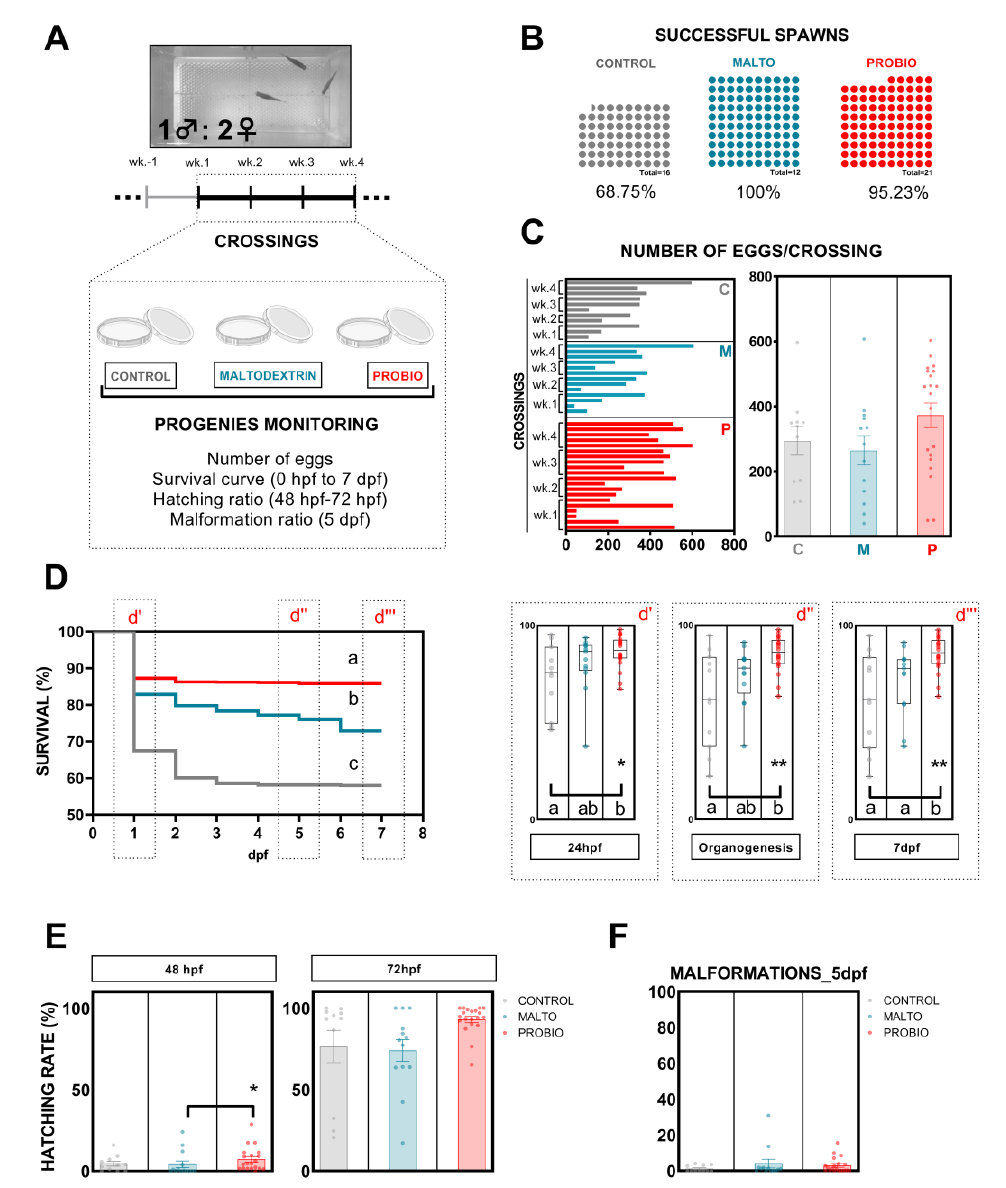
Figure 3. Probiotic ingestion positively affects zebrafish reproduction in terms of egg production and progeny quality. ( A ) Diagram summarizing design and all parameters analyzed involving each progeny. ( B ) The effect of experimental diets on the percentage of successful spawns, ( C ) total number of eggs spawned per crossing, ( D ) F1 survival (Kaplan–Meier curves (0–7dpf) and Box graphs (whiskers show min. to max.) at different key temporal points), ( E ) hatching rate at 48 hpf and 72 hpf, and ( F ) malformation rate. Data are presented as means ± s.e.m. “CONTROL/C”, “MALTO/M”, and “PROBIO/P” refer to the experimental groups: control diet-fed, maltodextrin-fed, and probiotics-fed, respectively. Asterisks show statistically significant differences: * ( p < 0.0500), ** ( p < 0.0100), and letters (a, b, c) show statistically significant differences among groups.